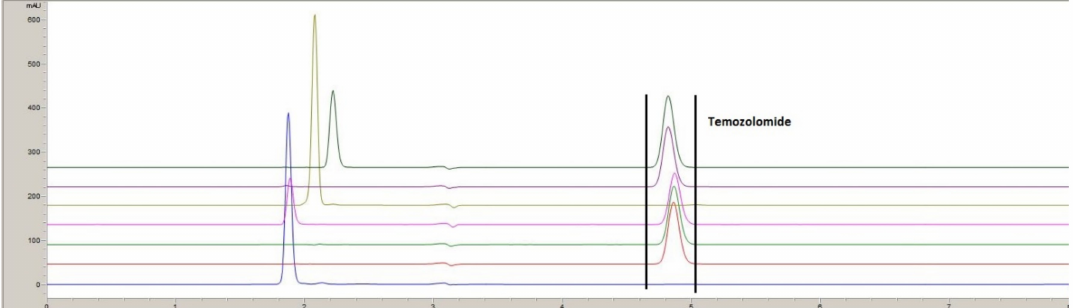
Figure 1. TMZ forced-degradation products chromatograms. Typical chromatogram of AIC reference (blue), TMZ reference (dark red), TMZ under acidic hydrolytic, HCL 1 N (green), TMZ under light exposure (i.e., 2 h of sun test) (pink), TMZ under basic conditions NaoH 1 N (in light green), TMZ under thermal stress 60 ◦ C, 24 h (purple), TMZ under oxidative conditions H 2 O 2 , 1% (dark green).